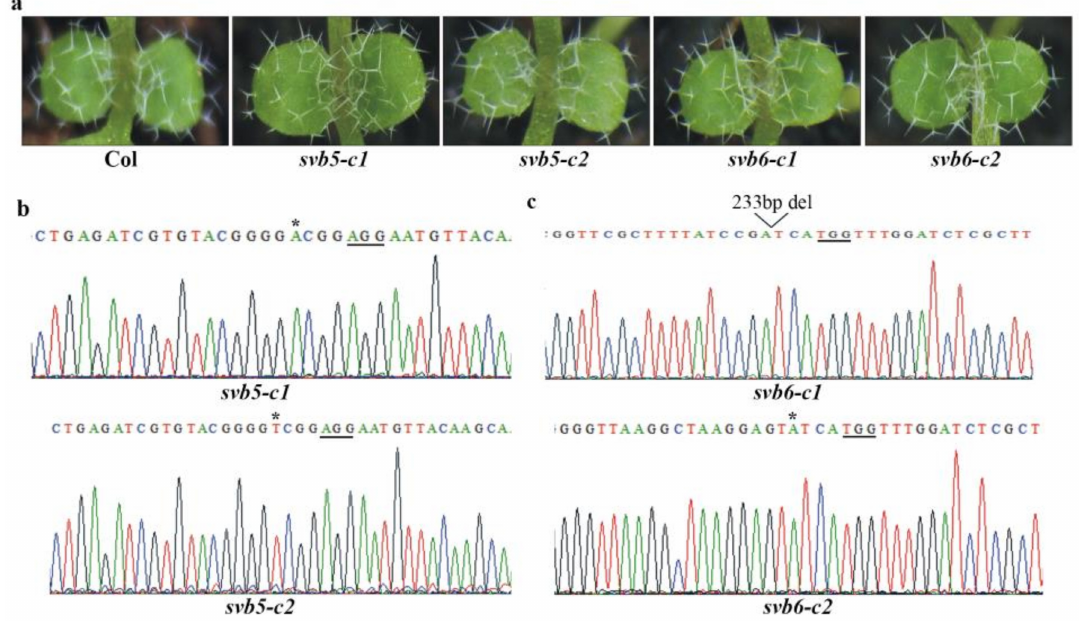
Figure 5. Mutations of SVB5 or SVB6 did not affect trichome development. ( a ) Trichome phenotypes of the Col wild type, the svb5 and svb6 single mutants. Seeds of the Col wild type, the svb5-c1 , svb5-c2 , svb6-c1 and svb6-c2 mutants were sown directly into soil pots and grown in a growth room, and trichome phenotypes on the first two rosette leaves of 8-day-old seedlings were examine under a Motic K microscope and pictures were taken by using an EOS 1100D digital camera connected to the microscope. ( b ) Editing status of SVB5 in the svb5-c1 and svb5-c2 mutants. DNA was isolated from normal flowering T2 plants, and sequenced. Underlines indicate the PAM sites, and stars indicate the single nucleotide insertion in the target sequences. ( c ) Editing status of SVB6 in the svb6-c1 and svb6-c2 mutants. DNA was isolated from normal flowering T2 plants, and sequenced. Underlines indicate the PAM sites, star indicates the single nucleotide insertion in the target sequence, and open arrow head indicates the site where a small fragment was